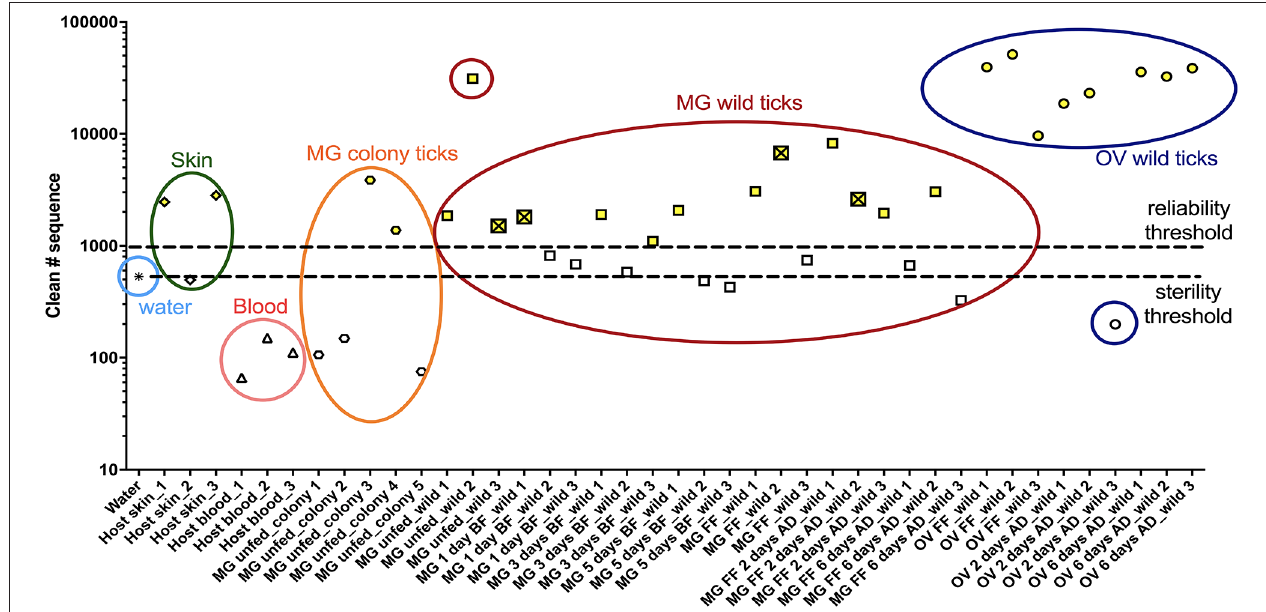
FIGURE 1 | Numbers of good quality 16S rDNA gene sequences obtained through bioinformatic analysis. Samples above both thresholds (yellow) were selected to bacterial diversity analysis. The crossed square represents a tick infected with Borreliella sp. MG, midgut; OV, ovary; UF, unfed; 1D, 1-day; 3D, 3-days; 5D, 5-days; FF, fully fed; AD, after